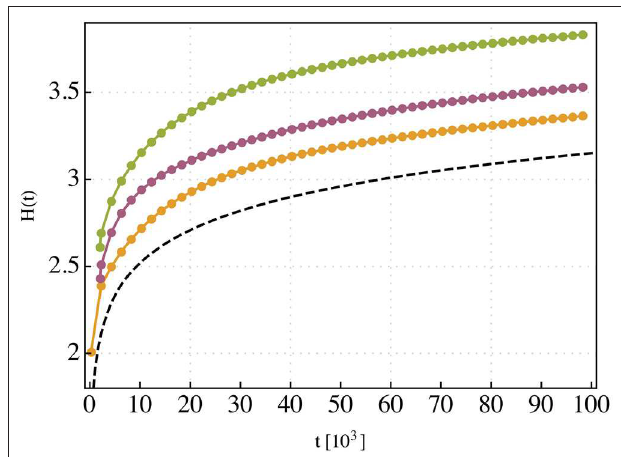
FIGURE 2 | The entropy associated with three randomly chosen initial positions inside the finger pattern. The point were chosen inside a circle of ∼ 50 % pattern radius in order to avoid the outer boundaries of the pattern. The dotted line is a reference line 0.62log 10 ( t ).